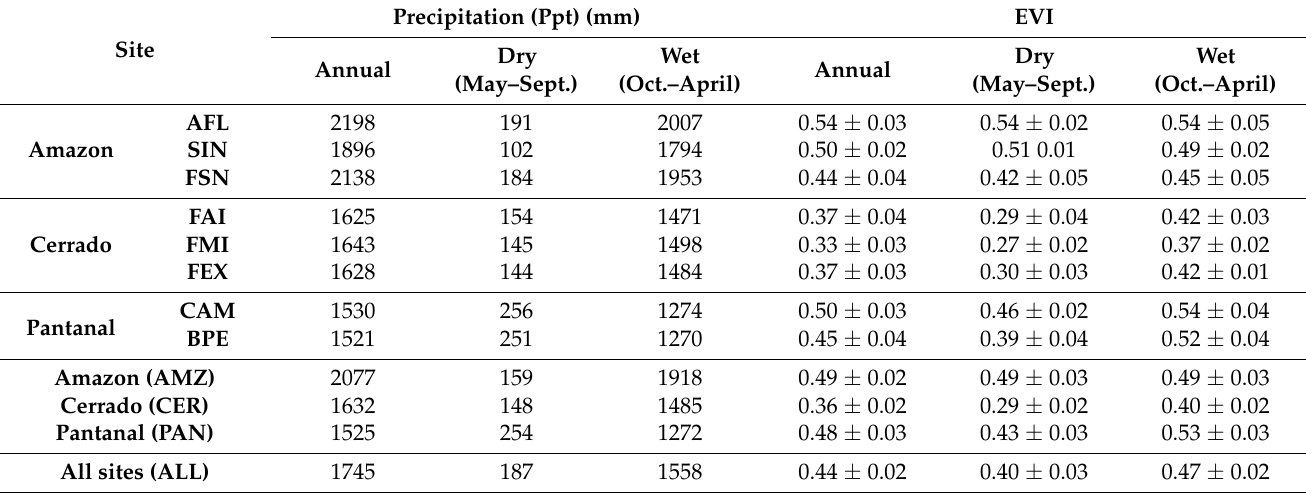
Table 3. Annual and seasonal accumulated precipitation (Ppt; mm) and mean (95% confidence interval) of the enhanced vegetation index (EVI; dimensionless) in each site, in the Amazon (AMZ), Cerrado (CER) and Pantanal (PAN) sites, and all sites (ALL).